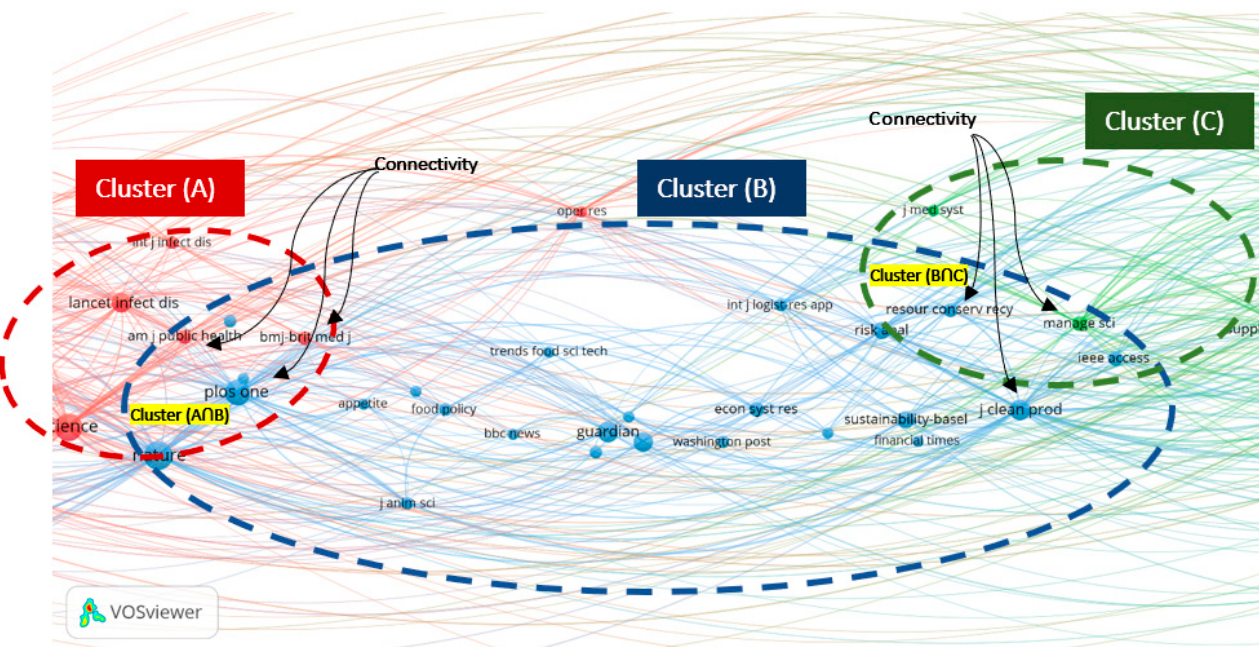
Figure 6. Stacked Author Network analysis.